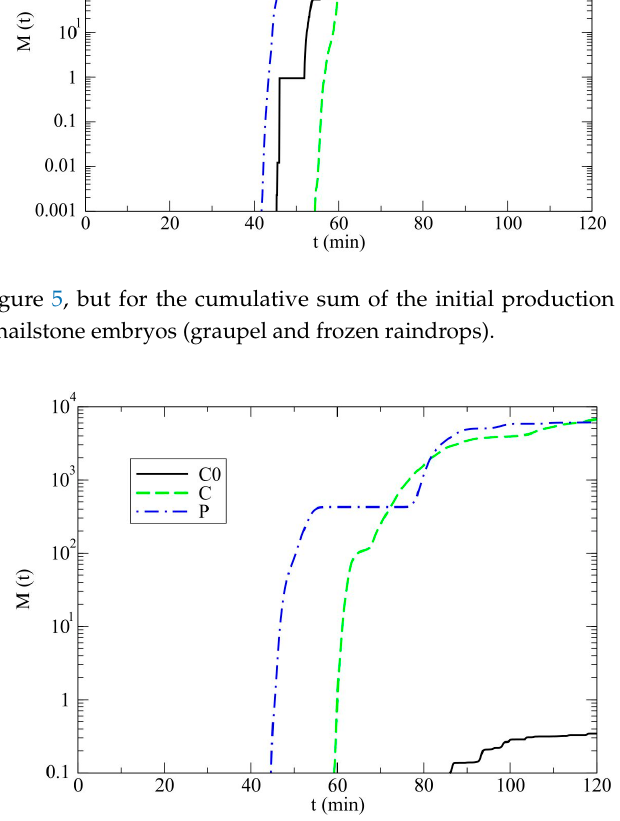
Figure 10. As in Figure 5, but for the cumulative sum of the mass contribution, M (tonnes) to hail based on accretion of cloud